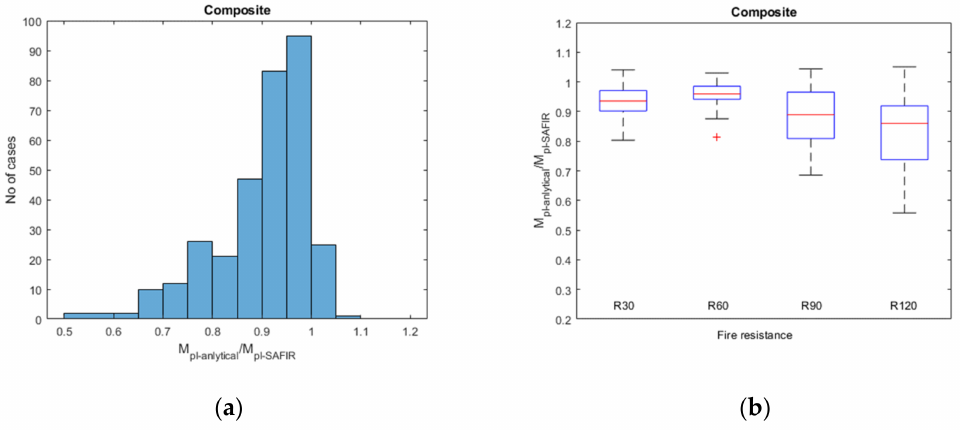
Figure 11. Assessment of the studied configurations with composite behavior: ( a ) Gauss curve, ( b ) boxplot